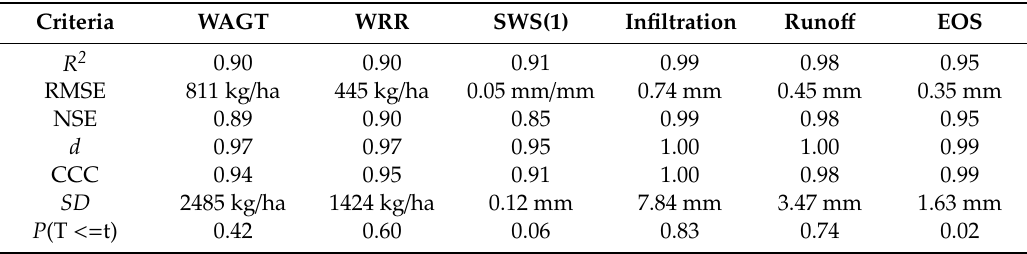
Table 2. Performance evaluation of the simulation accuracies of the measurement-based and PTF-based